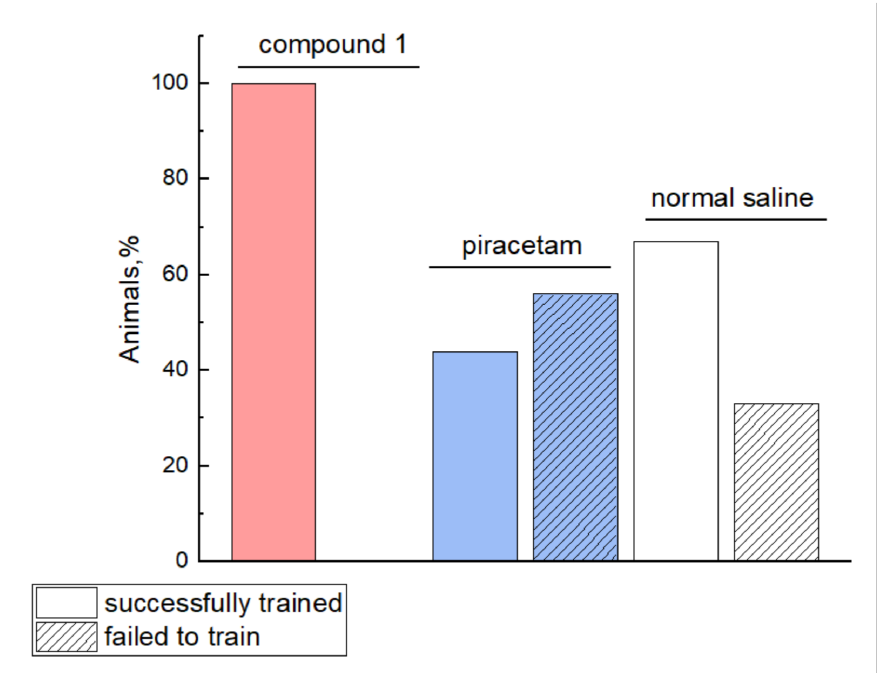
Figure 6. Beam walking test success rate. Animals were trained three times per day during 3 days before MCAO and on days 12–14 after MCAO. On day 14 after MCAO, the test and the number of steps, errors, and slides were counted. Solid bars represent animals who reached the black box. Stripes represent animals who fell from the beam, stood still, or turned back towards the light. No animals failed in compound 1 treated group (pink), more than half of the animals in piracetam group (blue) failed the training, and 30% of the animals failed in the normal saline group.